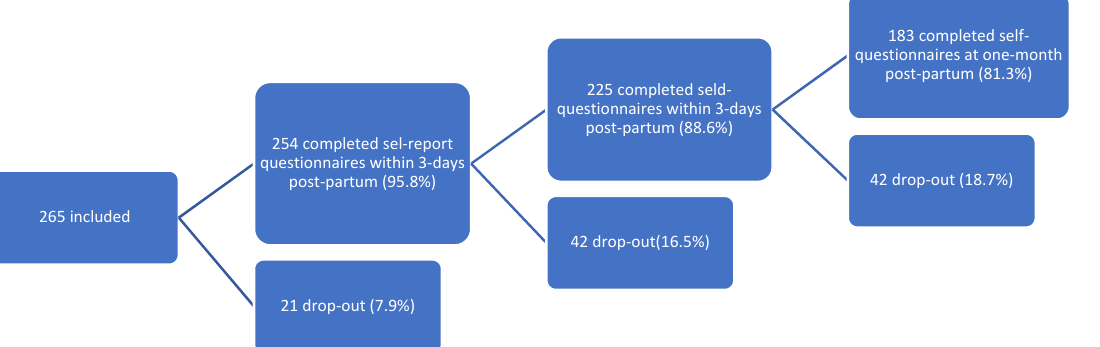
Figure 1. Flowchart of inclusion of women admitted for delivery between 25 January 2021 and 10 March